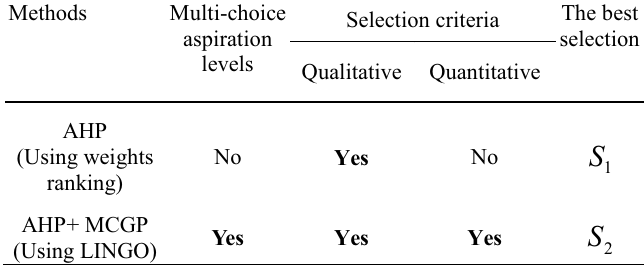
Table 5. Comparison of KMS service selection methods